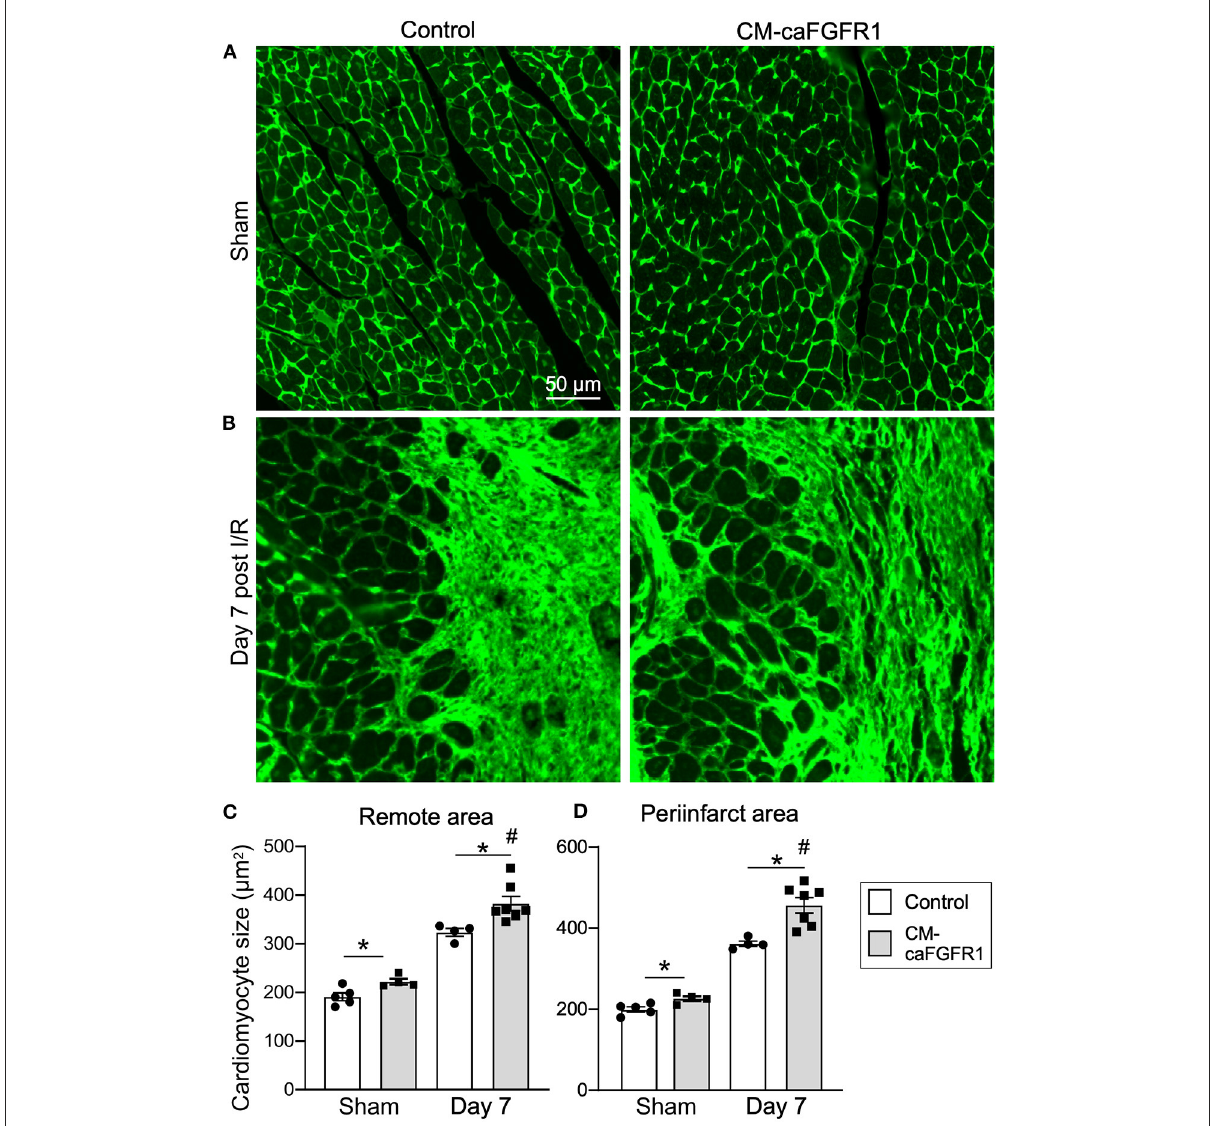
FIGURE6 The cardiac hypertrophic response after I/R injury is minimaly affected by transient FGFR1 activation in myocytes. (A,B) Representative images of WGA (FITC, green) stained cardiomyoctyes in the LV free wall of Control and CM-caFGFR1 hearts at 7 days after sham operated (A) or I/R injury (B) . (C,D) Quantitation of myocyte cross sectional area in the septum [ (C) , Remote area and (D) , periinfarct area] shows a small increase in the cardiomyocyte area in CM-caFGFR1 hearts at baseline and 7 days after ischemia. Scale bar = 50 µ m; n = 4–8; # P < 0.05 vs. sham (of the same genotype); * p < 0.05 vs.